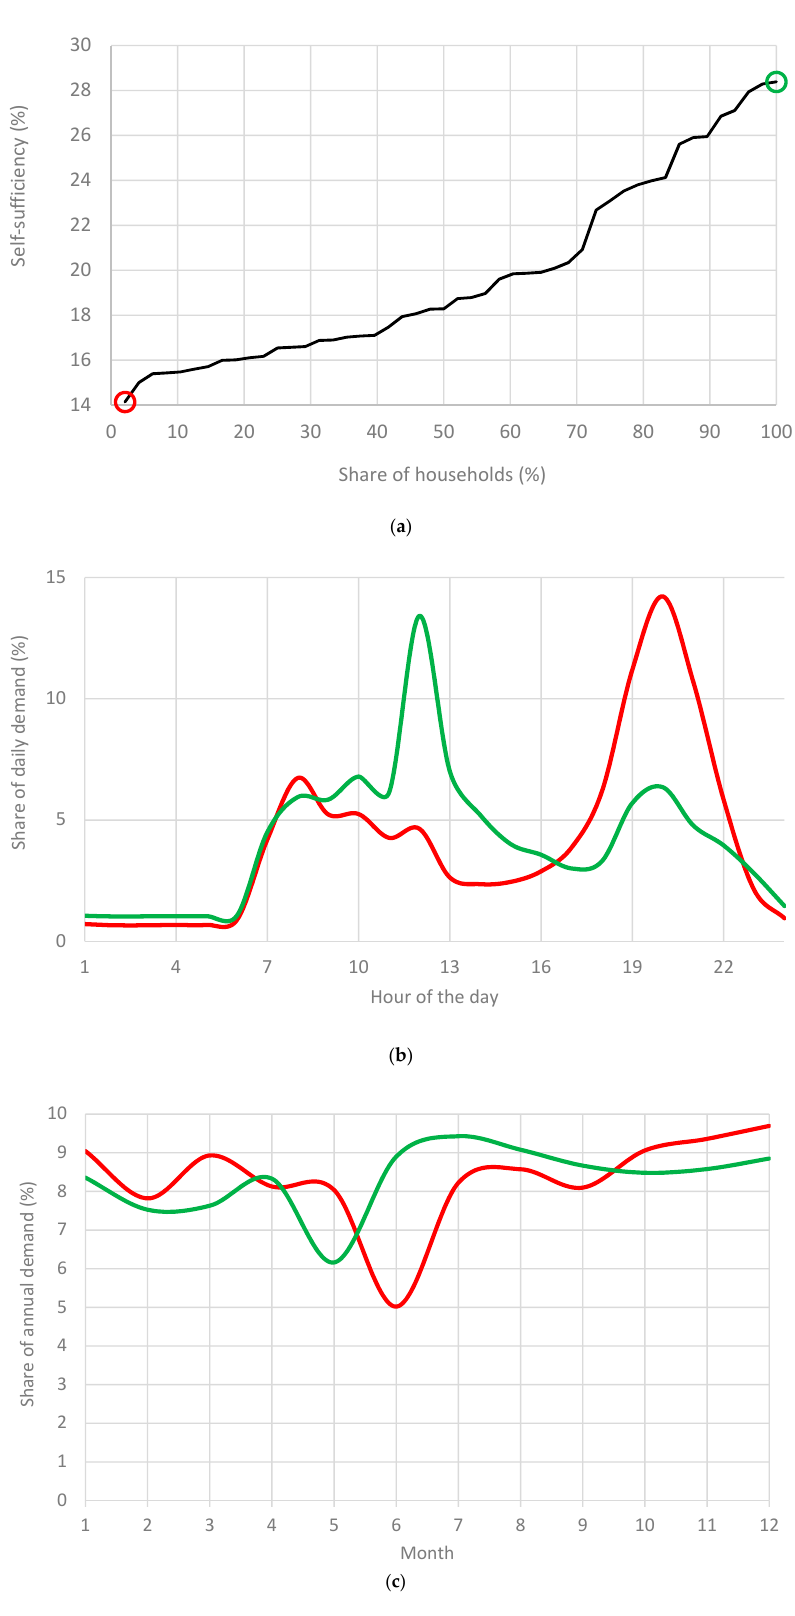
Figure 7. Self-sufficiency of the apartments in the local grid: ( a ) the distribution of self-sufficiencies across the 48 households; ( b ) the hourly average of the extreme households; and ( c ) the monthly average consumption of the extreme households.